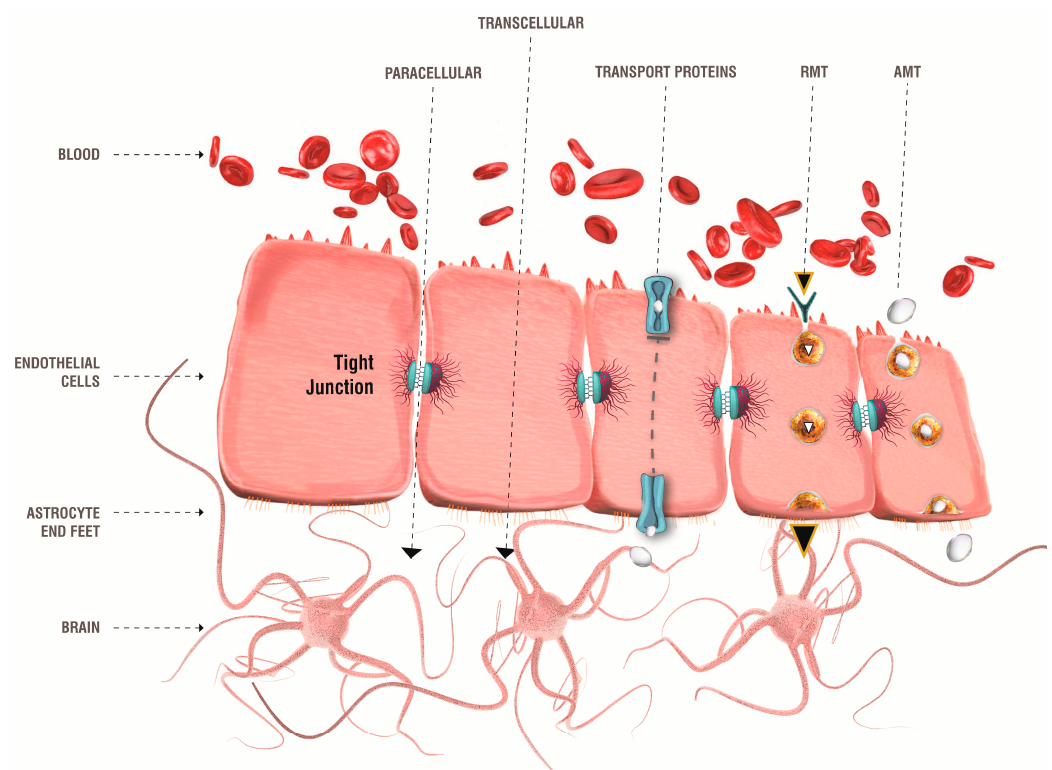
Figure 6. Schematic representation of the main methods for BBB crossing. AMT: adsorption-mediated transcytosis, RMT: receptor-mediated transcytosis.